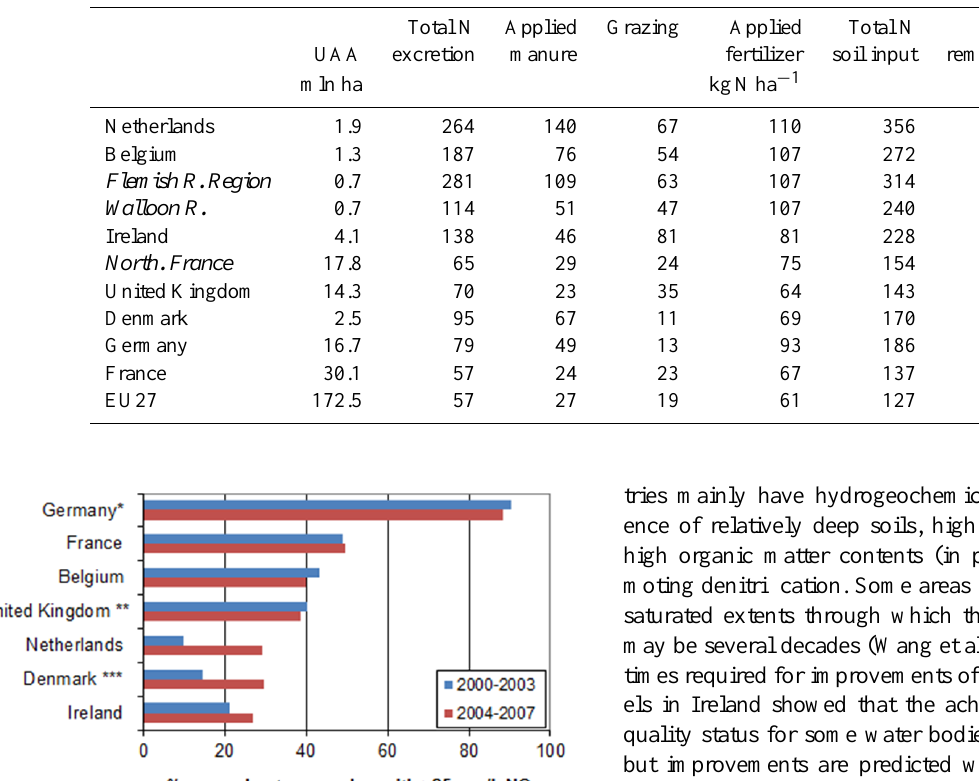
Table 10. Annual N inputs, removal of soil N balance in 2008 in northwestern member states of the EU according to MITERRA ranked with SNB.